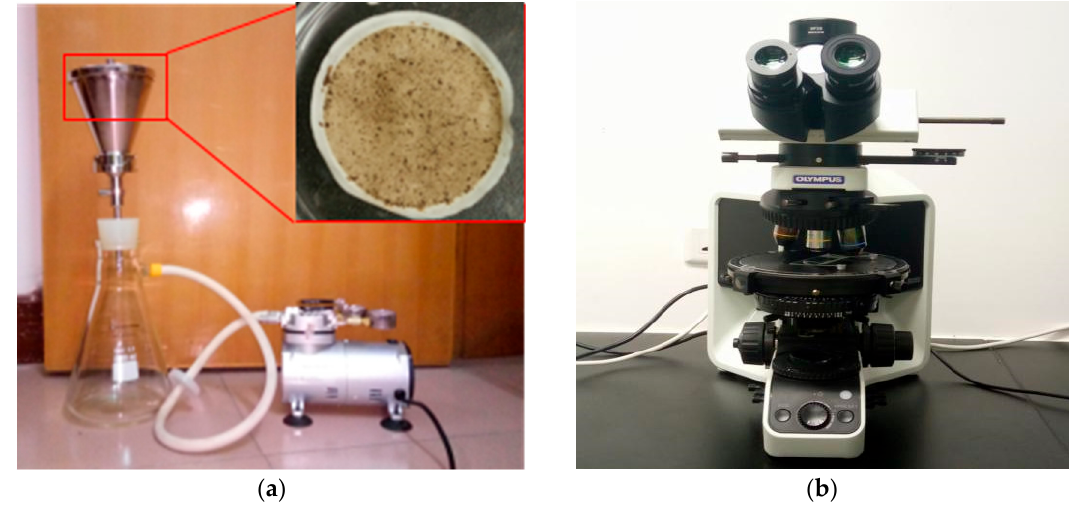
Figure 7. ( a ) Experimental filter device; ( b ) polarizing microscope.